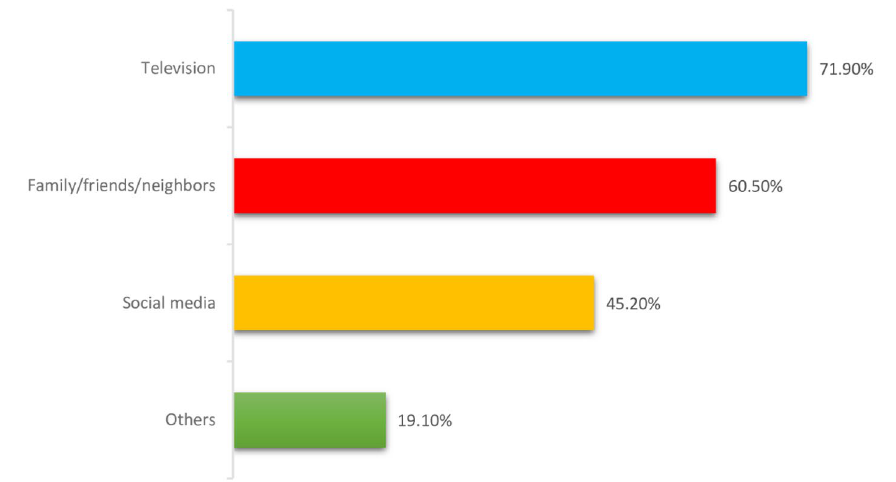
Figure 1. Sources of information used by pregnant women about